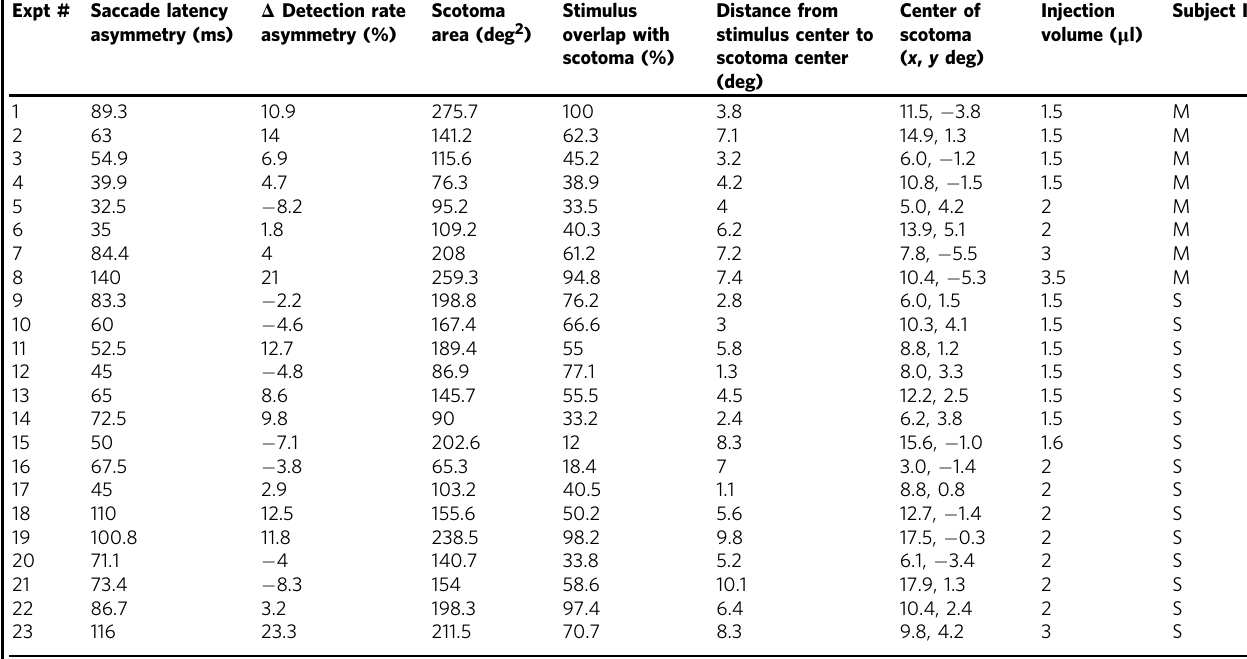
Table 2 Summary of muscimol injections performed in the FEF Expt # Saccade latency asymmetry